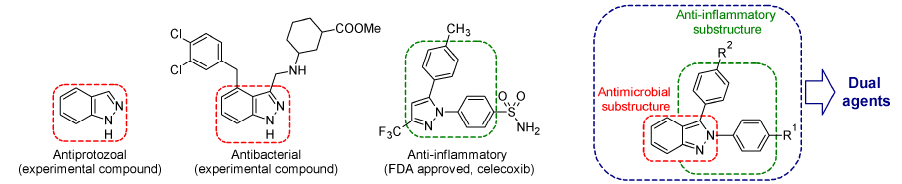
Figure 1. Design of the 2,3-diphenyl-2 H -indazole derivatives.